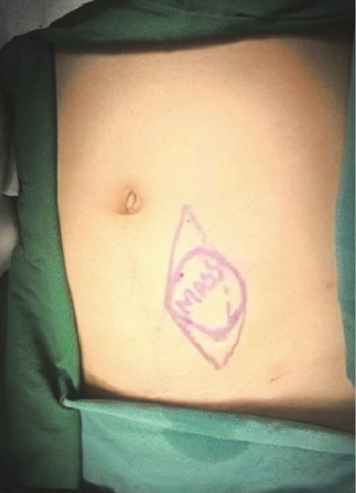
Figure 1: Palpable mass in the infraumbilical region to the left of the midline.